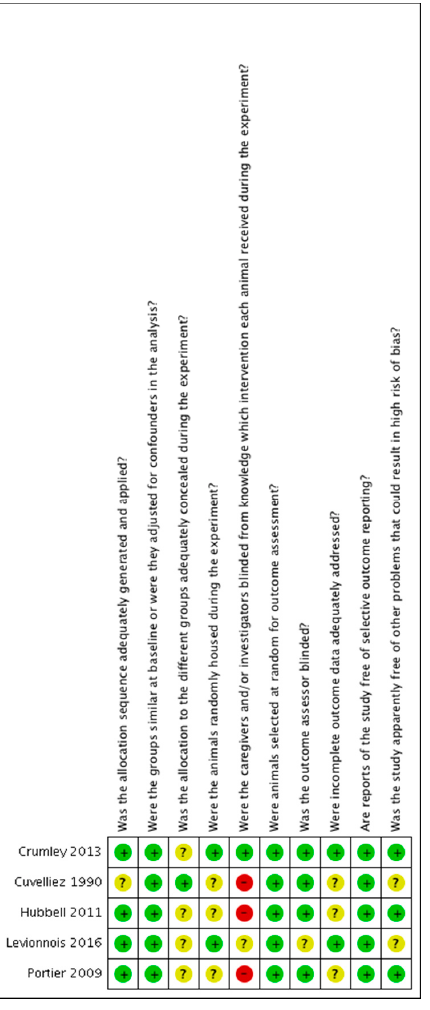
Figure 3. Risk of bias summary: review authors' judgements about each risk of bias item for each included study. ?: unclear risk; -: high risk; +: low risk.